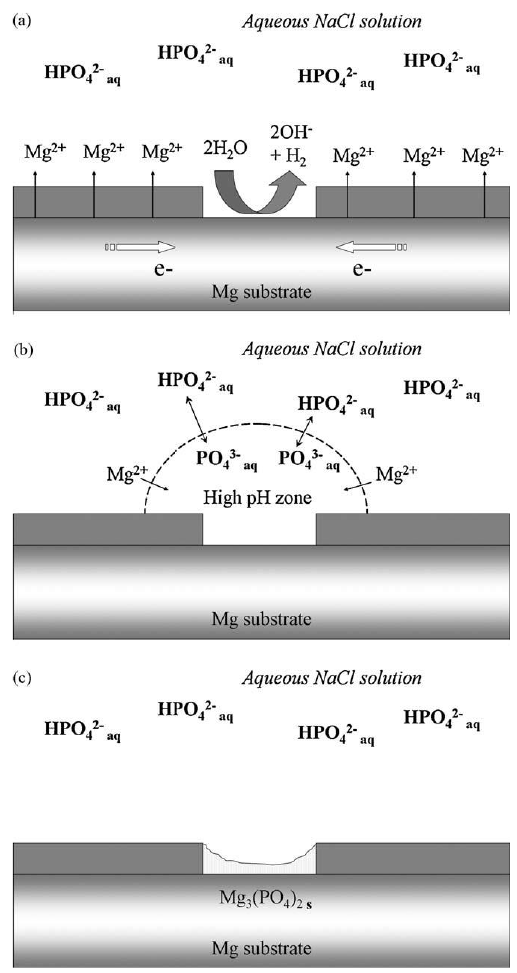
Figure 2. Schematic representation of the mechanism of magnesium corrosion inhibition by aqueous phosphate ions at neutral pH, showing ( a ) localization of the early stages of corrosion, ( b ) phosphate speciation in the vicinity of the local cathode, and ( c ) deposition of an insoluble film [21]. Adapted from [21] with permission from Elsevier.